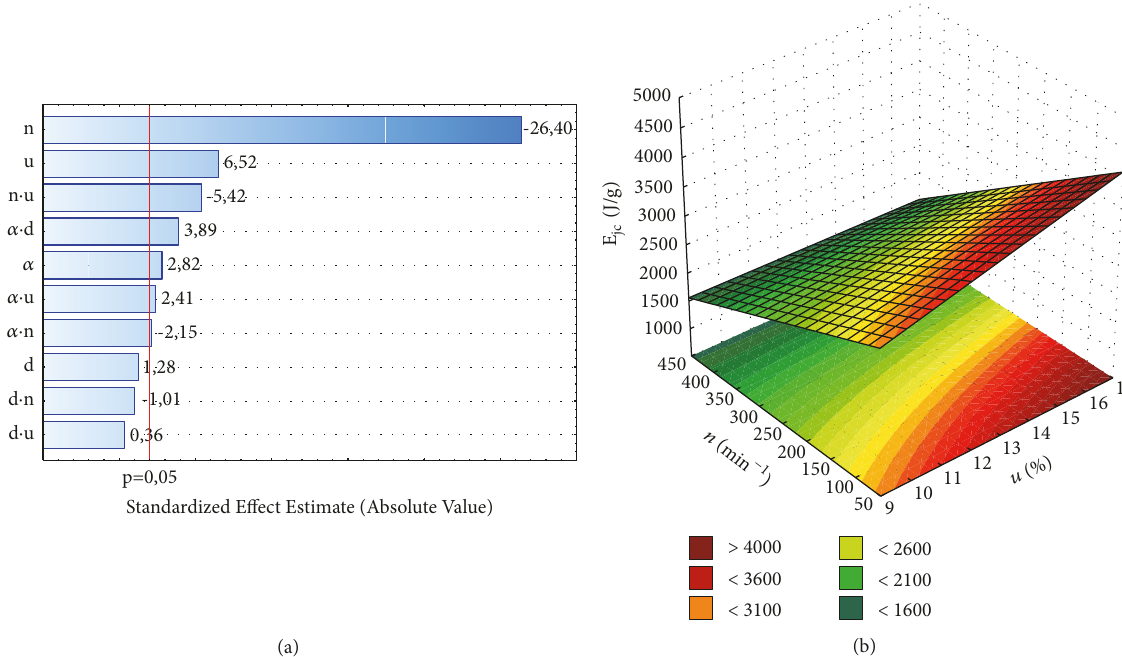
Figure 10: Model of specific energy consumption of the extruder E jc . (a) Pareto chart of standardised effects of the regression model, (b) response surface versus the screw rotational speed n and the mass fraction of talc